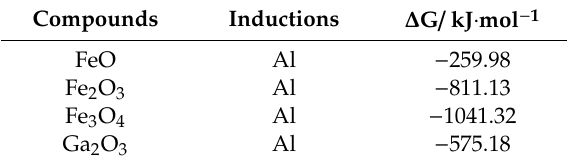
Table 1. Reaction Gibbs energy of iron oxidation and Al (T = 873.15 K).